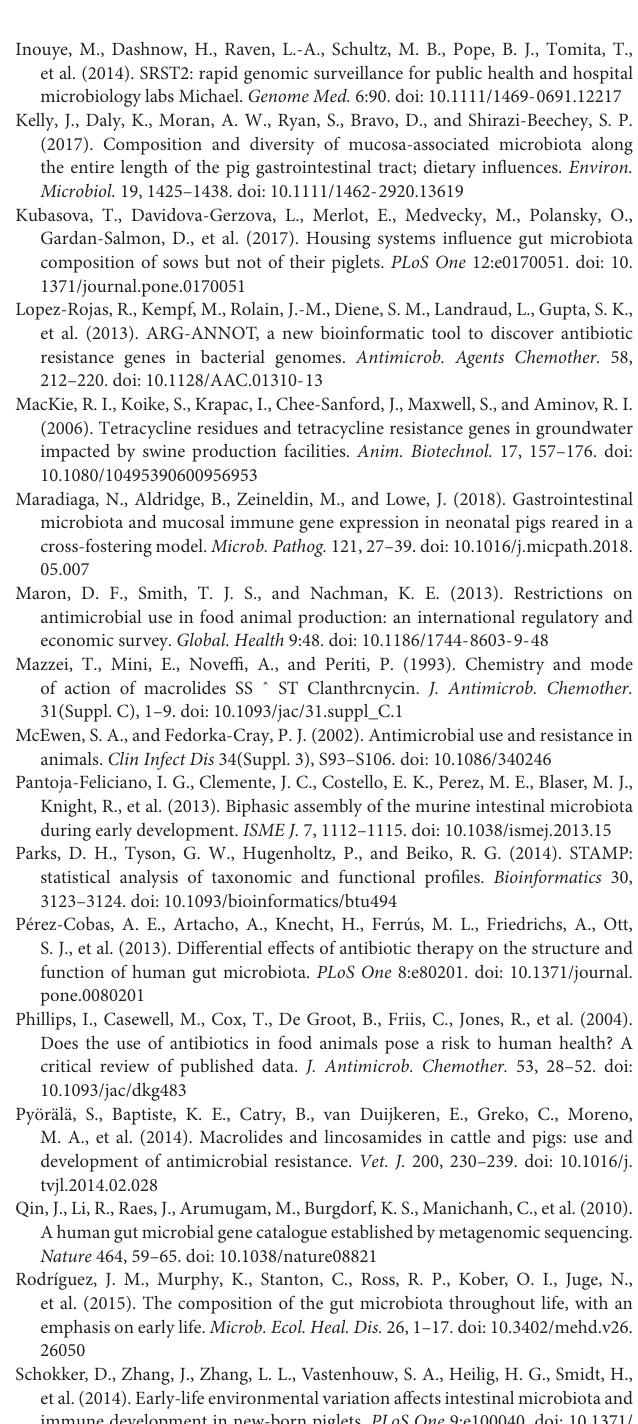
and tulathromycin (TUL) piglets at different sampling days (0, 5, and 20). The individual data points, which represent bacterial diversity for each piglet, are depicted. Error bars represent the standard errors. TABLE S1 | The most predominant 100 microbial species across all the samples in both control (CONT) and tulathromycin (TUL) treated